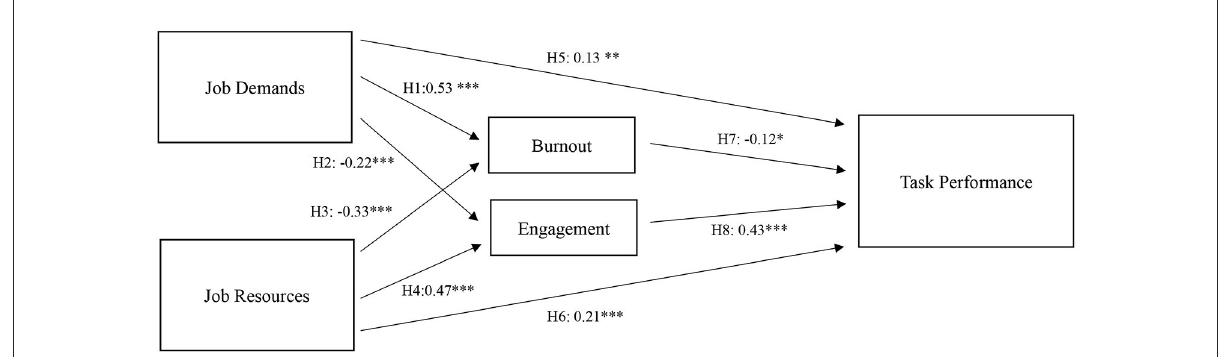
FIGURE2 Standardized estimates of the hypothesized model. N = 537; * p < 0.05, ** p < 0.01, *** p <